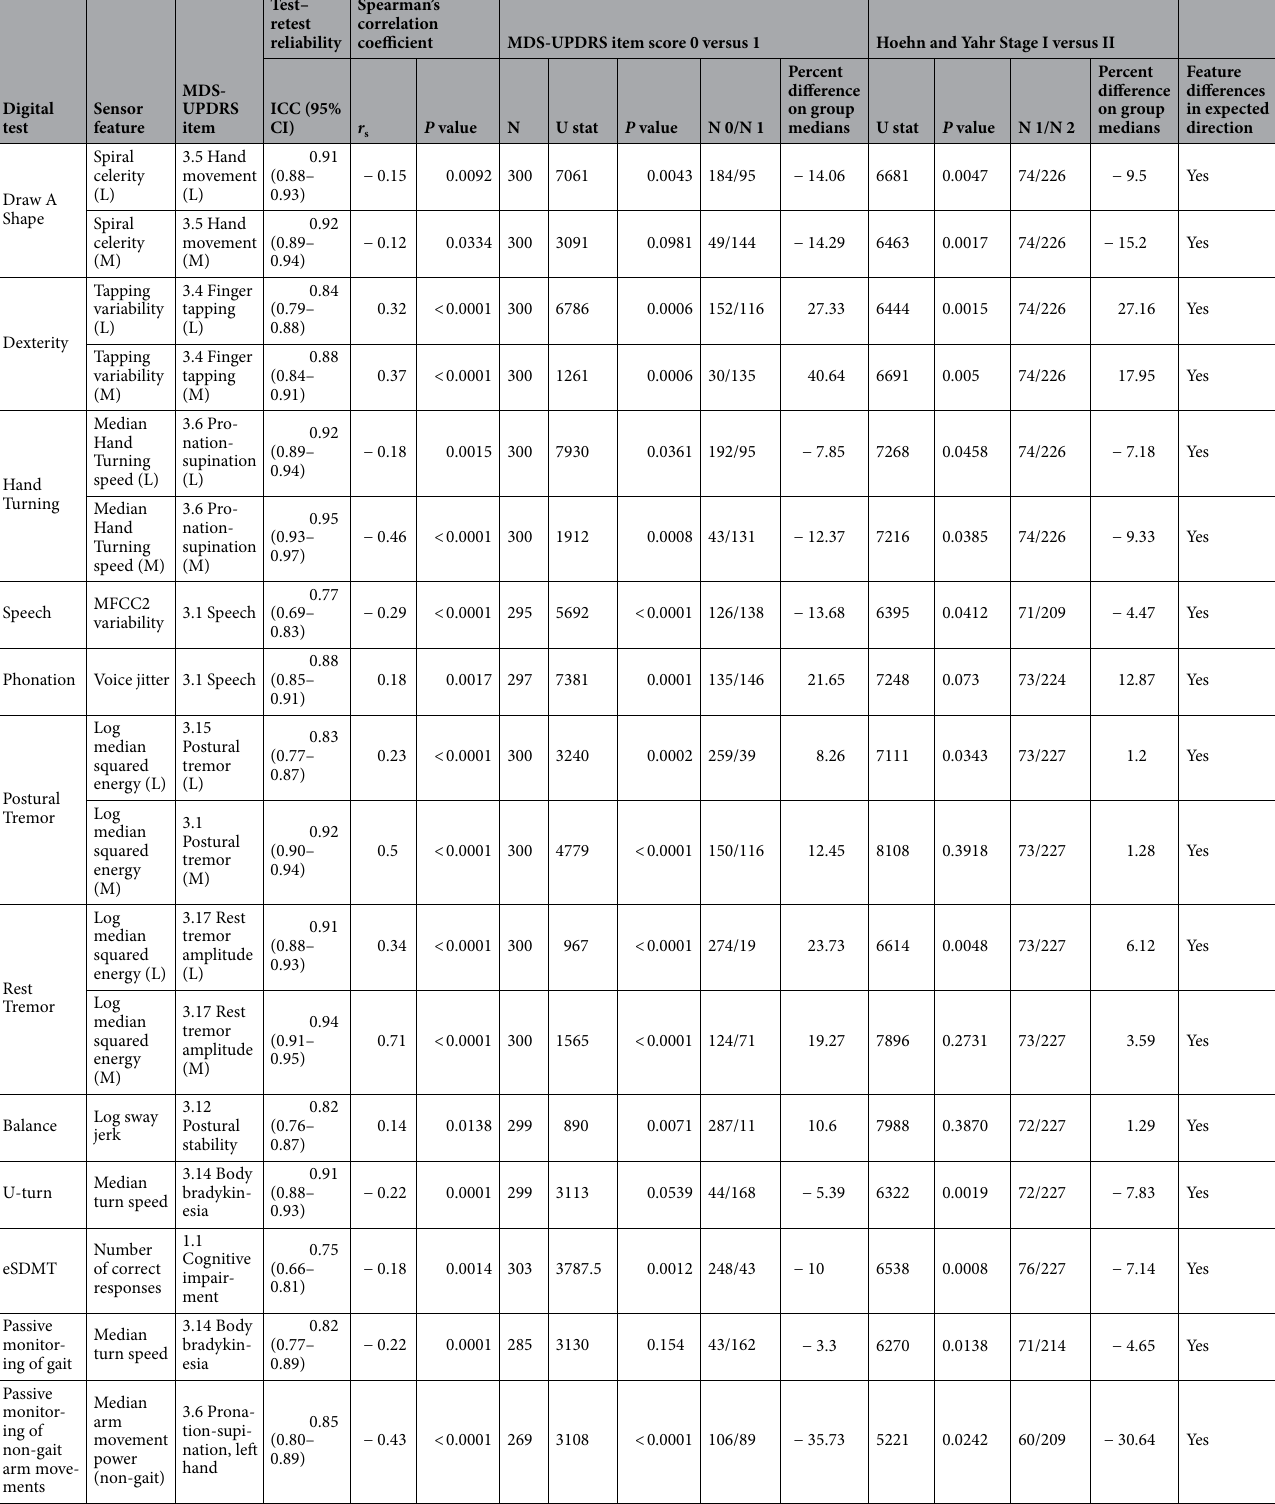
Table 1. Reliability and clinical validity of pre-specified Roche PD Mobile Application v2 active test and passive monitoring sensor features. “M” = most affected side; “L” = least affected side. CI confidence